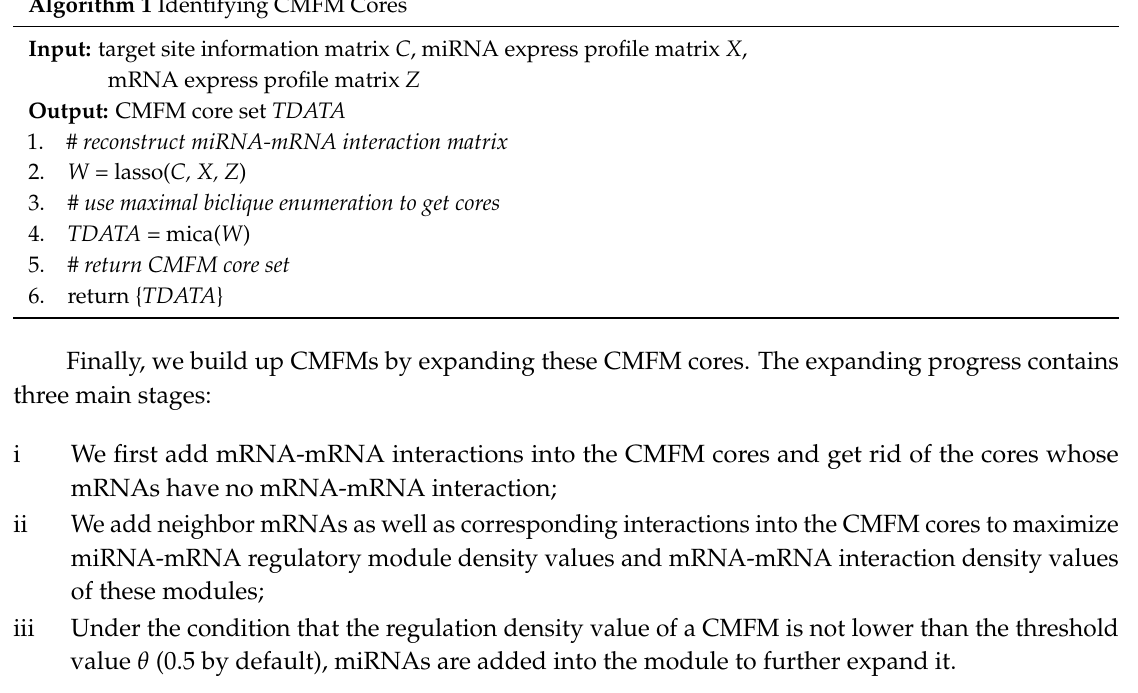
Algorithm 2 Expanding Cores to CMFMs